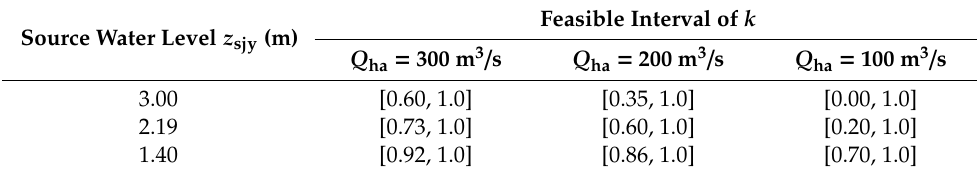
Table 3. Feasible interval of k under the constraints of water level and flow rate.